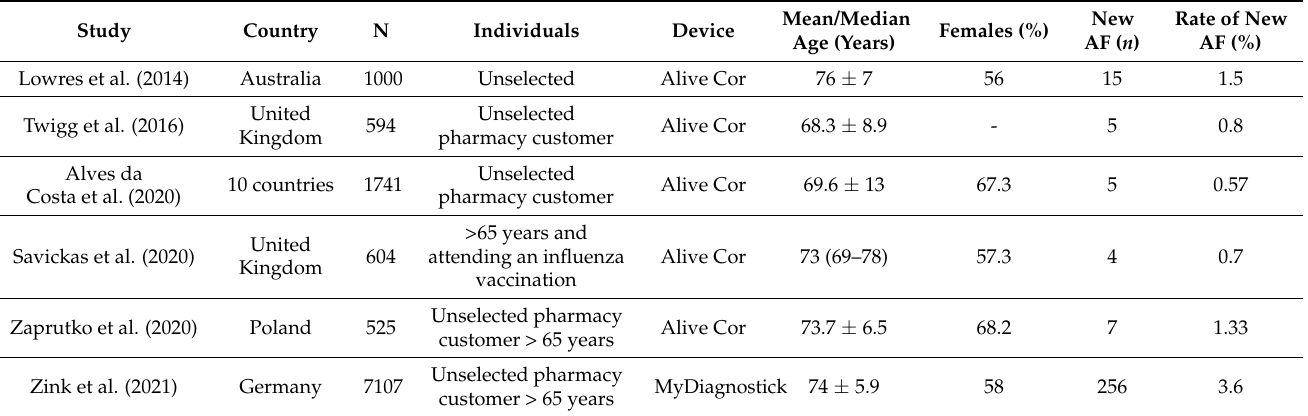
Table 4. Summary of trials investigating AF detection using single-lead ECG devices and setting in